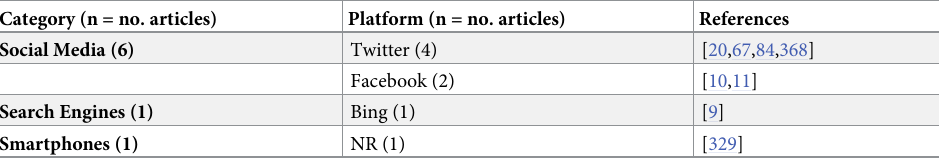
Table 21. Number of articles predicting religion, with associated platforms and references.